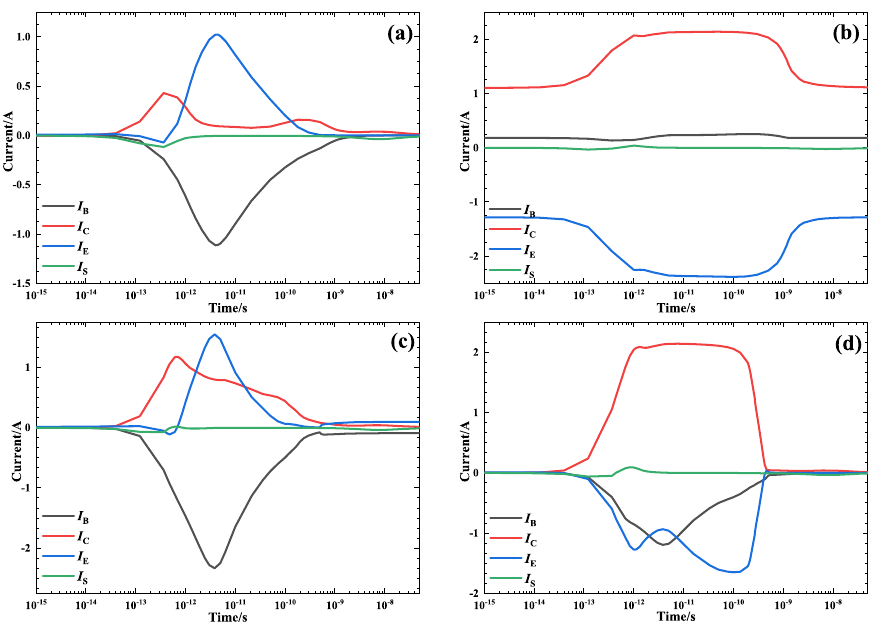
Figure A1. Change in current with time when heavy ions vertically irradiate the base of the SiGe HBT under the substrate inverse bias ( a ), positive bias ( b ), off bias ( c ) and collector positive bias ( d ) states.